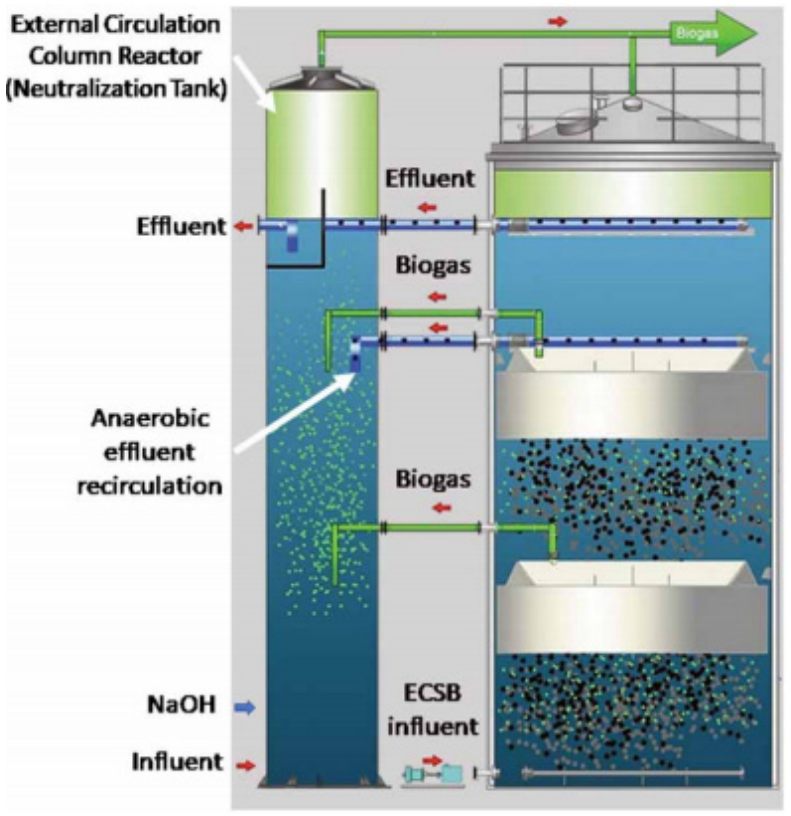
Figure 7. Schematic representation of the ECSB reactor coupled with an external circulation tank [50]. An innovative solution was proposed by Torres et al. [51], who carried out several experimental tests on laboratory scale reactors seeded with sludge coming from wastewater treatment plants (WWTPs) located in Spain. The reactors operated in sub-mesophilic conditions at different hydrodynamic regimes, varying the upflow velocity from 0.10 m/h (UASB) to 3 m/h (EGSB), assisted by chitosan. The latter was used to demonstrate that its presence in the start-up phase favors the formation of compact microbial granules from the flocculant. Not only was their hypothesis confirmed, but the solid retention was also independent of the hydrodynamic conditions inside the reactors. This means that this solution can be applied to both UASB and EGSB reactors. Debowski et al. [52] tried to overcome the limitations of the anaerobic treatment of wastewater by means of the innovative solution of the fluidized active filling reactor (FAF-R). During their experiment, the effect of FAF on sugar industry effluent was tested at different organic loading rates (OLR), more precisely from 4 to 6 kgCOD/m 3 d. The results showed that, within this OLR range, the COD removal efficiency was greater than 74% and the methane yield was greater than 70%. However, when the OLR was increased up to 8 kgCOD/m 3 d, the effluent treatment efficiency strongly decreased mainly due to the pH reduction. Similar work is proposed by Dohdoh et al. [53], who analyzed the effect of carrier filling media inside a UASB reactor. In their work a comparison is made between an integrated fixed-film anaerobic sludge (UASB-IFAS) and a traditional UASB with activated sludge (UASB-AS). Both systems showed high organic matter and ammonia removal efficiency under different operating conditions in which organic loading rate (OLR), hydraulic retention time (HRT), temperature and other parameters were varied. In particular, the hybrid solution showed greater stability when hydraulic and organic loads were changed. Optimum HRT was found at 6 h with 95% COD removal efficiency and increasing the temperature improved system